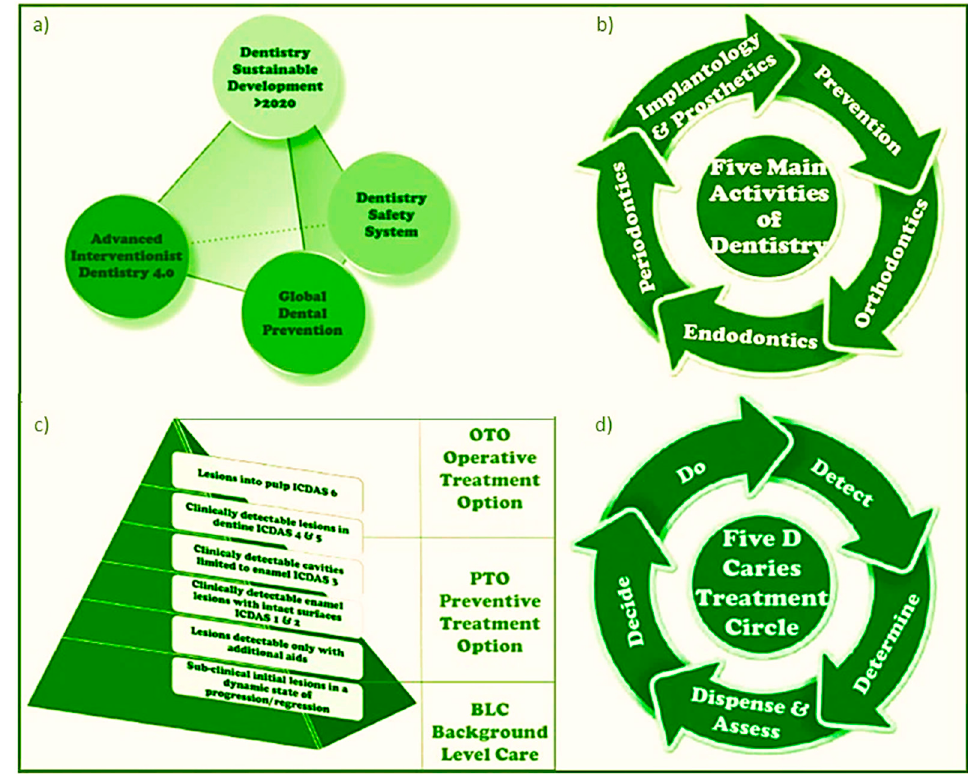
Figure 7. Models relating to dentistry: ( a ) sustainable development of dentistry; ( b ) the rules of the five main activities of dentistry (5MAD); ( c ) caries development pyramid (CDP) with indications from primary care (BLC) to preventive treatment options (PTO) and surgical treatment options (OTO); ( d ) 5D caries management cycle (CMCRs) principles for continuous improvement of the patient’s oral